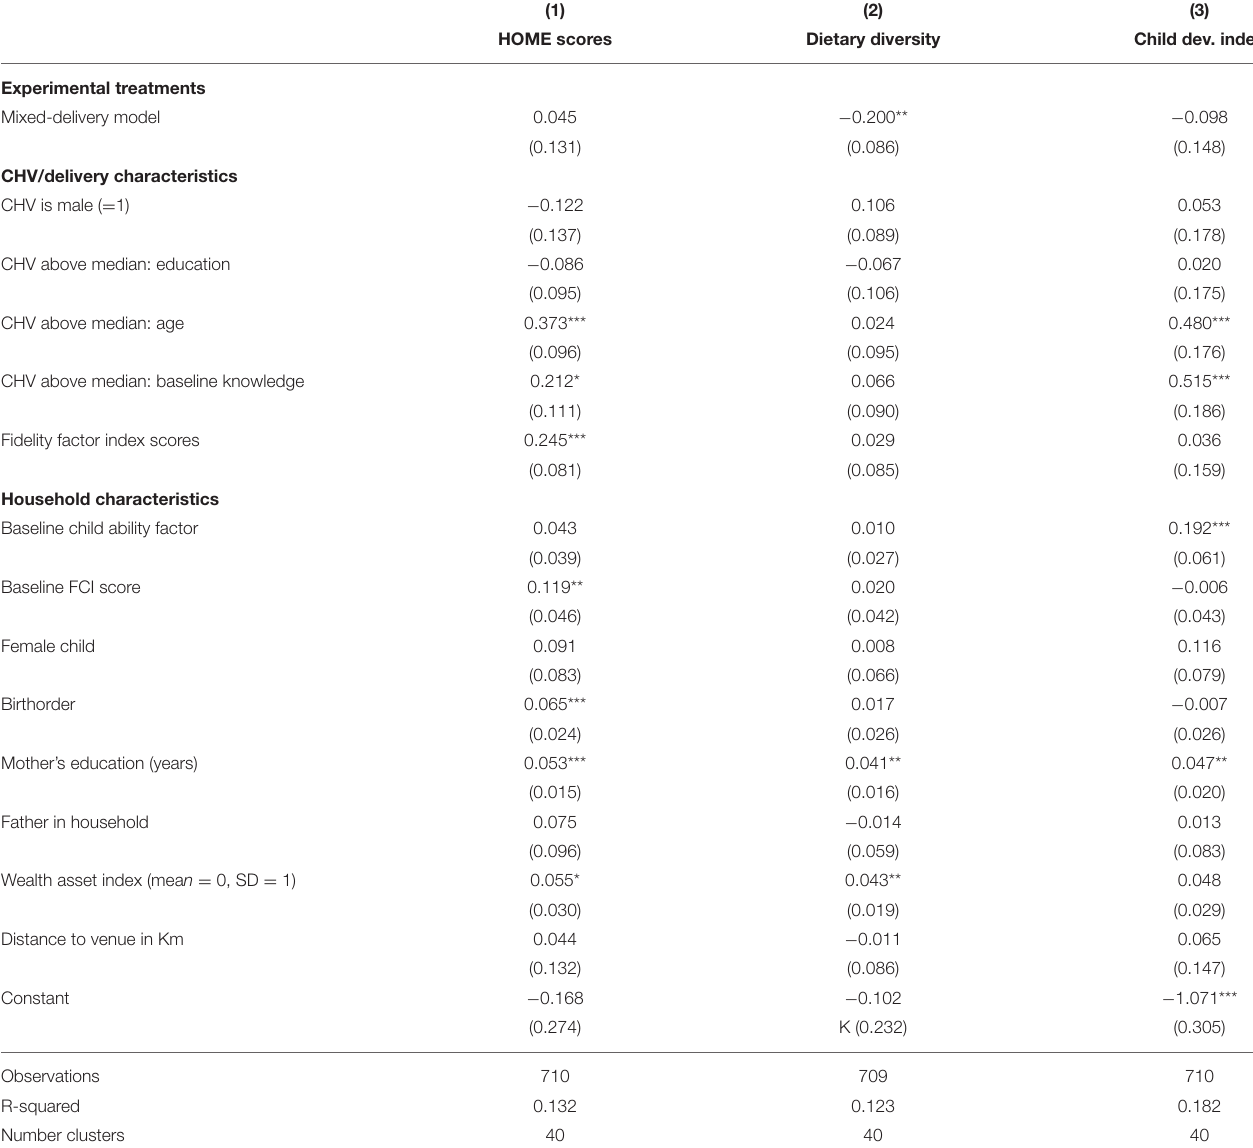
TABLE 7 | Determinants of final outcomes. (1) (3) HOME scores Dietary diversity Child dev.